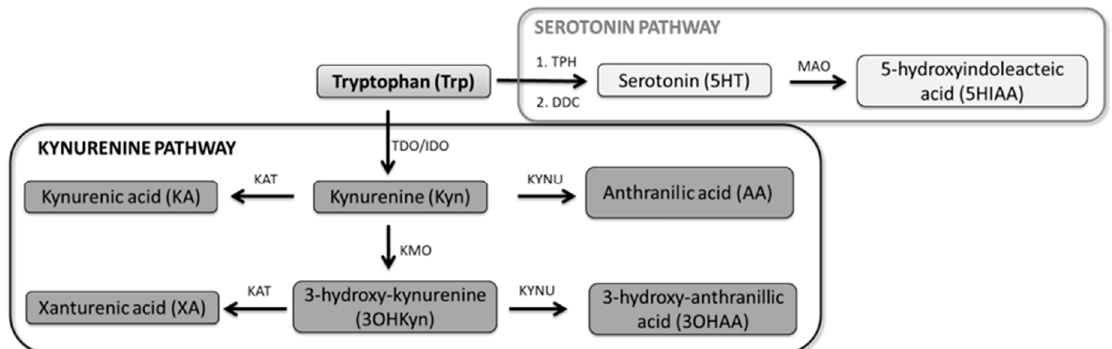
Figure 1. Tryptophan metabolic pathways. Metabolites involved in the tryptophan system including serotonin and kynurenine pathways. TPH, tryptophan hydroxylase; DDC, aromatic L-aminoacid decarboxylase; MAO, monoamine oxidase; IDO, indoleamine 2,3-dioxygenase; TDO, tryptophan 2,3-dioxygenase; KAT, kynurenine aminotransferase; KYNU, L-kynurenine hydrolase; and KMO, kynurenine 3-monooxygenase.